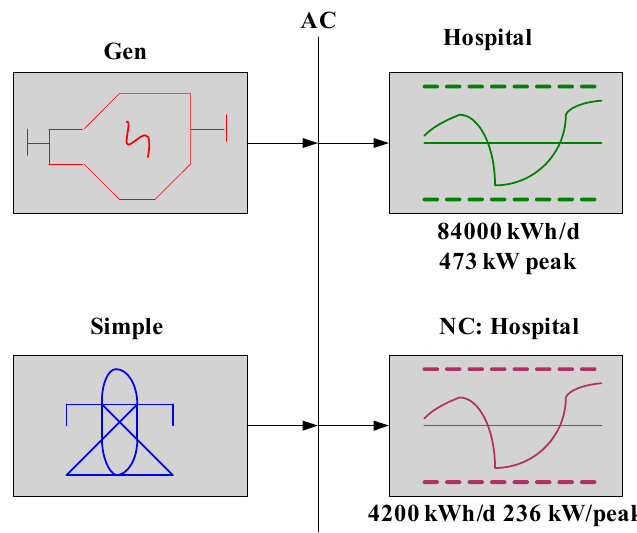
Figure 10. System 1: HOMER grid configuration.